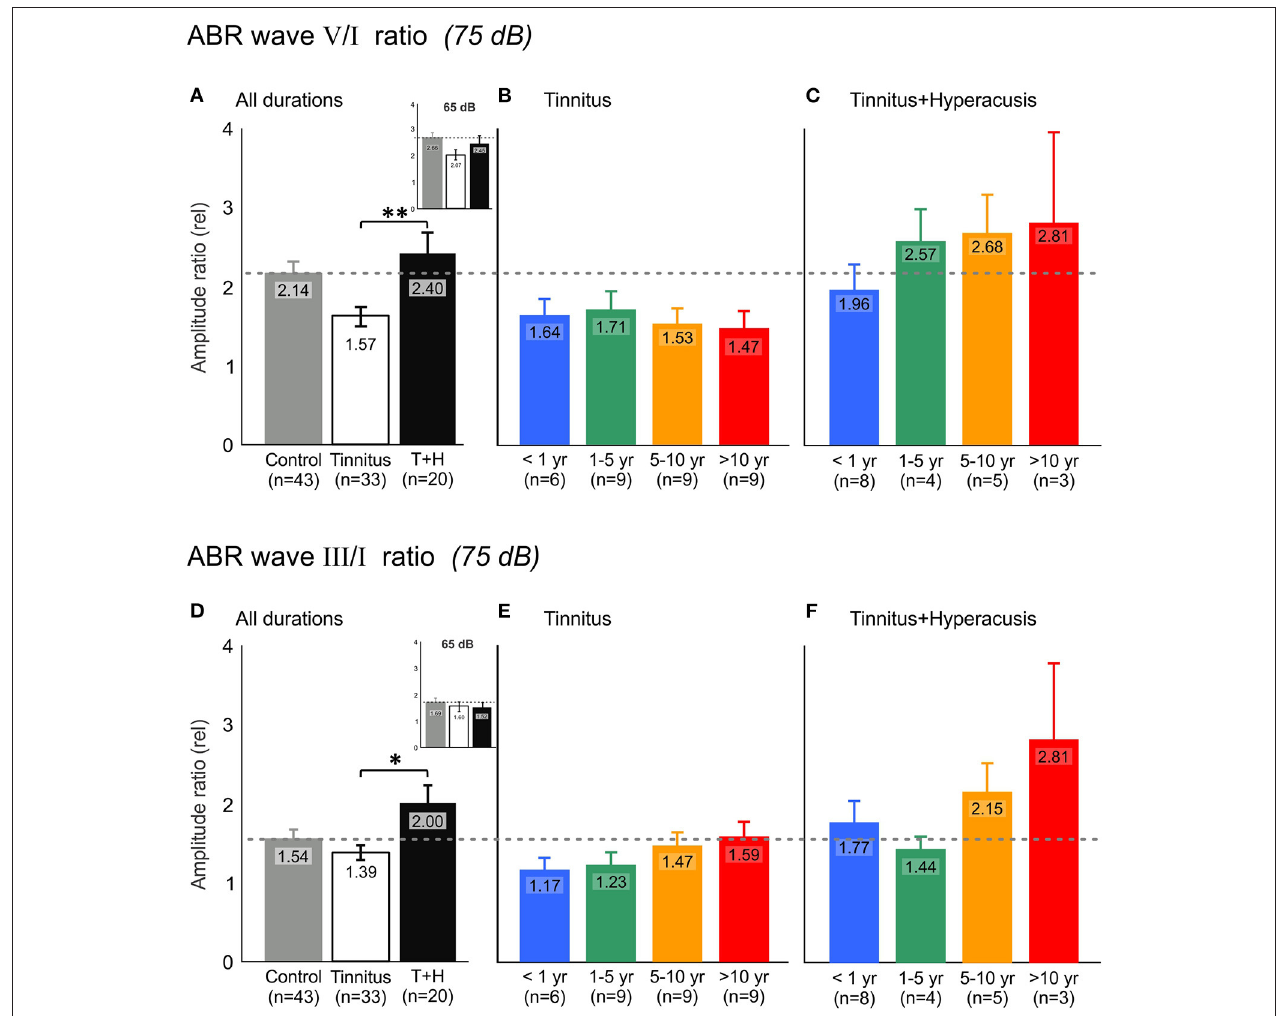
FIGURE 7 | Auditory brainstem response (ABR) wave V and wave I relation (V/I ratio) demonstrates increased auditory response gain in tinnitus + hyperacusis participants but not in participants with tinnitus only. (A) ABR wave V/I amplitude ratio averaged for all participants of tinnitus (open bar) and tinnitus + hyperacusis (black bar) participants for 75 dB nHL click stimulus evoked ABR responses compared to healthy controls (gray bar). The inserts show the result at 65 dB nHL. Higher values illustrate a larger auditory output/input relation, that is, a higher efficiency of the auditory input (wave I, generated in the auditory nerve) to generate a larger wave amplitude within the auditory midbrain (wave V, refers to inferior colliculus), referred to as auditory central gain. (B,C) ABR wave V/I ratio for participants with tinnitus and tinnitus + hyperacusis, respectively, categorized according to the time of persistence of their tinnitus (tinnitus duration). The horizontal dashed line marks control level. (D) ABR wave III/I ratio illustrating the efficiency of the auditory input (wave I, generated in the auditory nerve) to generate a larger wave amplitude within the auditory brainstem (wave III, refers to the superior olivary complex), referred to as auditory brainstem gain. (E,F) ABR wave III/I ratio for participants with tinnitus and tinnitus + hyperacusis, respectively, categorized according to their tinnitus duration. At 75 dB nHL T, TH: V/I: P = 0.001, III/I: P = 0.026, 65 dB nHL T, TH: V/I: P = 0.286, III/I: P = 0.958 using Mann-Whitney U -test. At 75 dB nHL T: V/I: P = 0.733, T: III/I: P = 0.430, TH: V/I: P = 0.613, TH: III/I: P = 0.596 using Kruskal-Wallis test. Data represent mean ± standard error (s.e.m.). Level of significance is illustrated in the figures (* P ≤ 0.05; ** P <